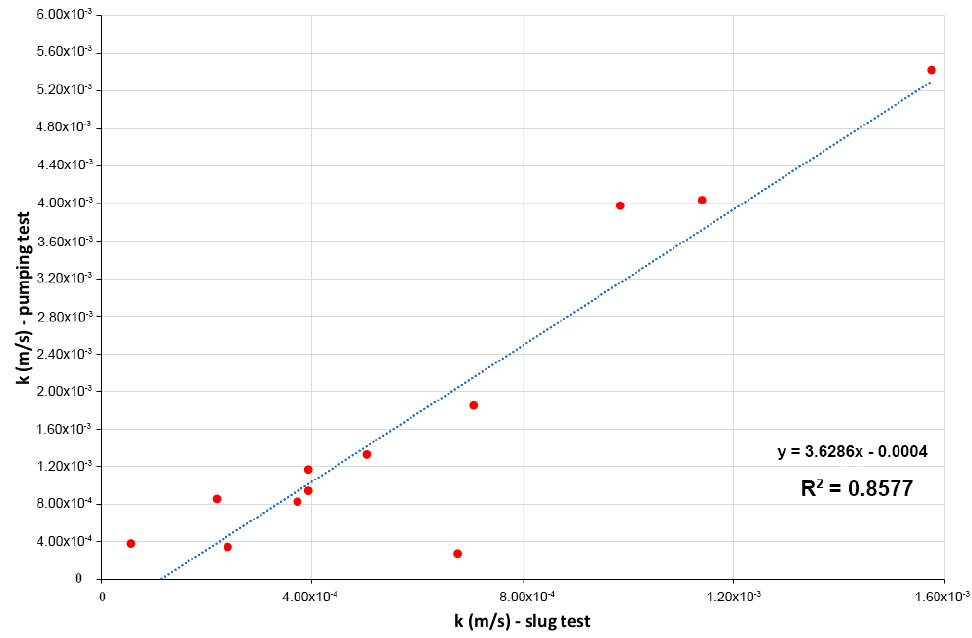
Figure 7. Binary plot showing the correlation (R 2 = 0.86) between the k-values obtained by the slug test survey and the pumping